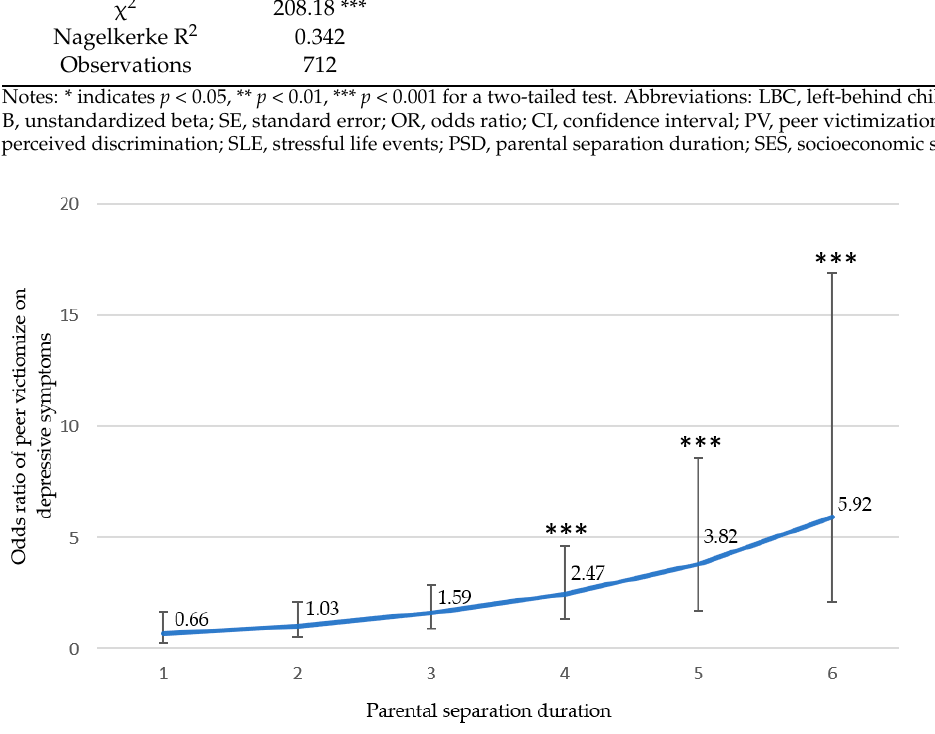
Figure 1. Odds ratios of peer victimization on depressive symptoms for different parental separation duration. Notes: *** indicates p < 0.001 for a two-tailed test. 1 = less than half a year, 2 = half a year to 1 year, 3 = 2 to 4 years, 4 = 5 to 7 years, 5 = 8 to 10 years, and 6 = more than 10 years.